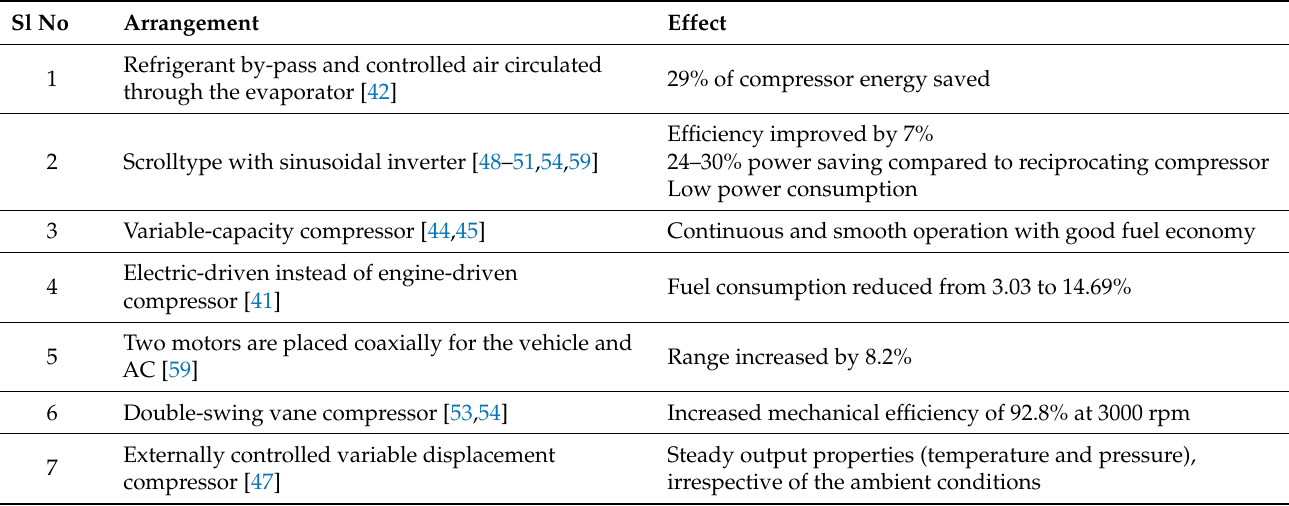
Table 3. Different compressors and their effects.